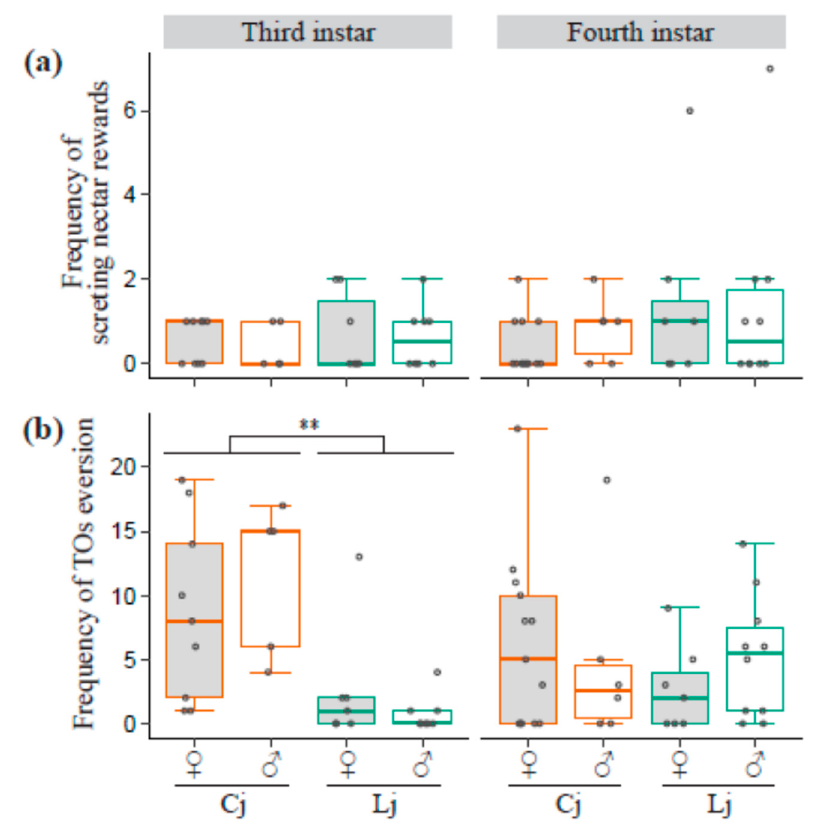
Figure 4. Frequency of nectar reward secretion and tentacle organs (TO) eversion. The boxplots show the frequency of nectar reward secretion ( a ) and TO eversion ( b ). The colors of the box outlines and the dots represent ant-tending conditions (Cj: orange, Lj: green). All the data points are shown as dots. Dots outside boxes and whiskers are outliers. The gray and white boxes represent female and male lycaenid larvae, respectively. ** indicates a significant difference between tending ant species.